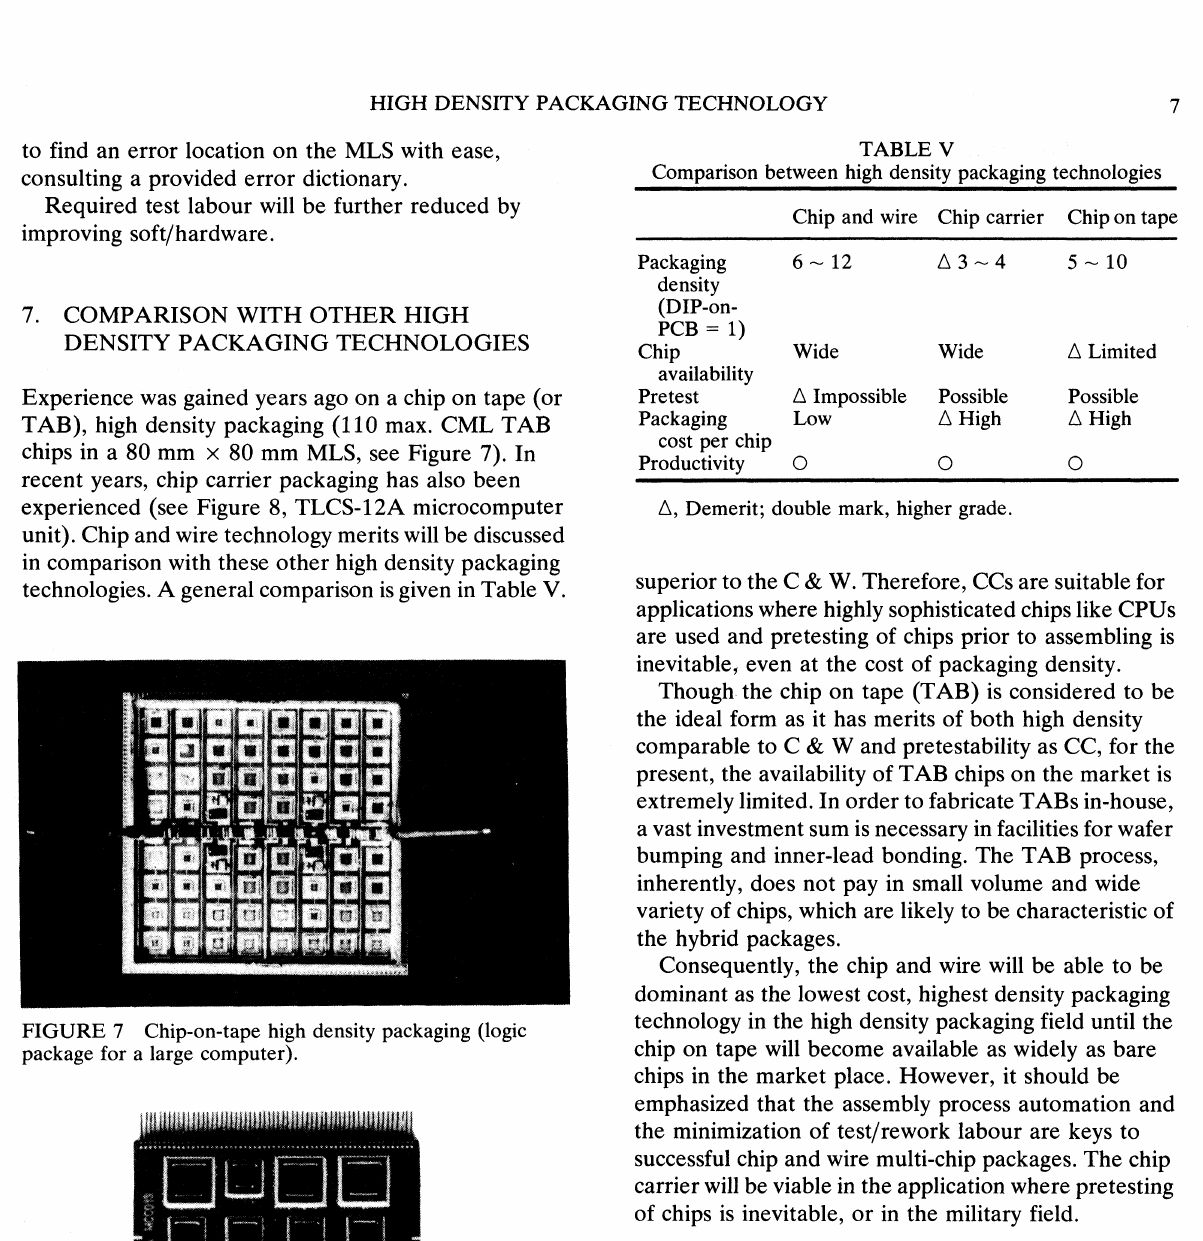
FIGURE 8 Chip carrier high density packaging (12 bit microcomputer unit).